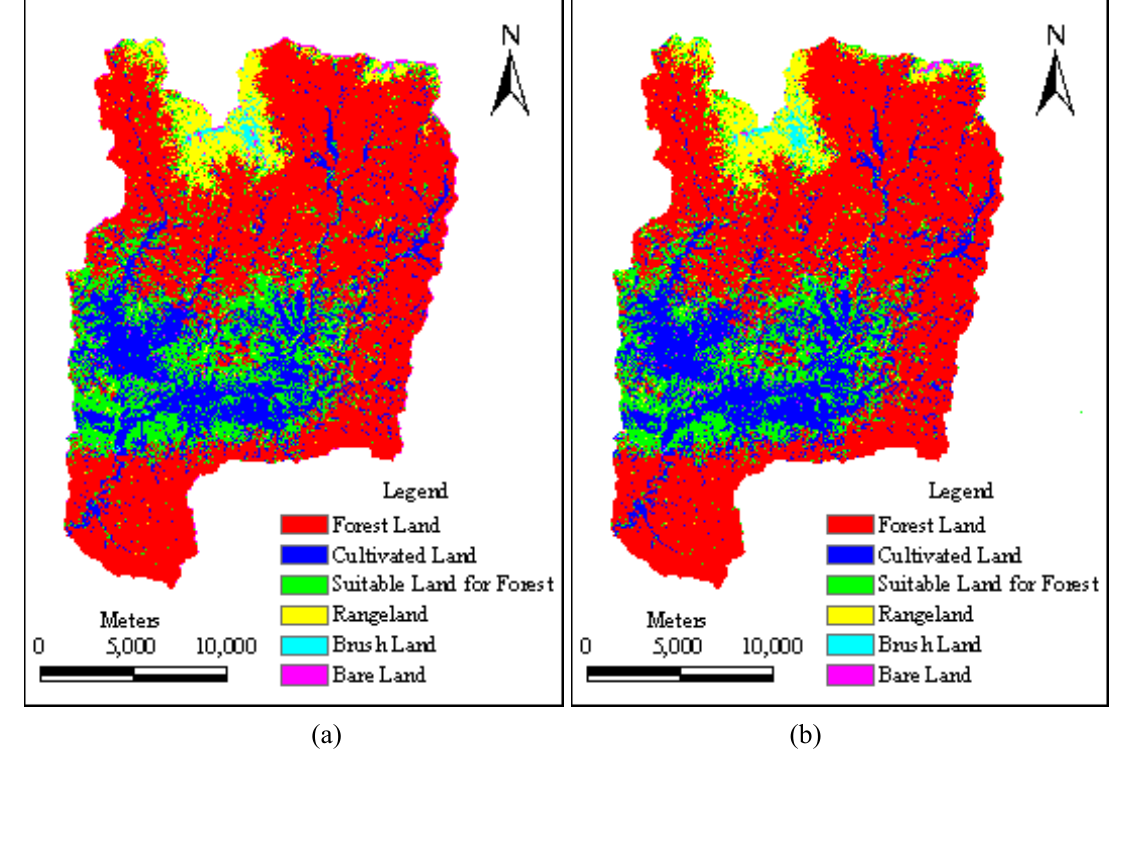
Figure 5. Image map of LULC Classification after topographic correction for the Yangjiahe river watershed: (a) and (b) illustrates the classification result after SCS correction based on SRTM DEM and the DEM constructed from 1:50,000 scale topographic map respectively; (c) and (d) exhibits the classification result after Minnaert correction based on SRTM DEM and the DEM constructed from 1:50,000 scale topographic map